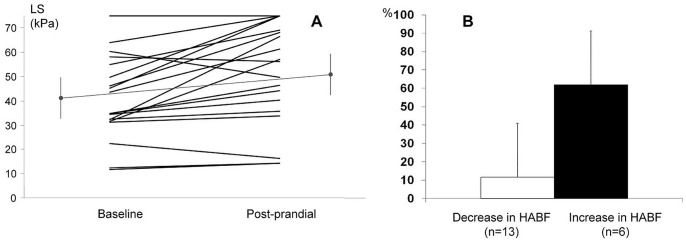
Changes in liver stiffness (LS) after a liquid test meal in the studied population of patients with cirrhosis (n = 19). Panel A.Individual changes of liver stiffness (LS) after the standard meal in the study population (n = 19). Baseline and post-prandial mean value (and standard deviation) are depicted in grey. Panel B. Changes in liver stiffness (LS) in patients showing a decrease in hepatic artery blood flow (HABF) post-prandially (column in white, n = 13) vs. HABF increased post-prandially (column in black, n = 6). As shown, patients showing a HABF decrease after the meal had a much lower increase of LS as compared to patients increasing HABF post-prandially (p<0.0001).